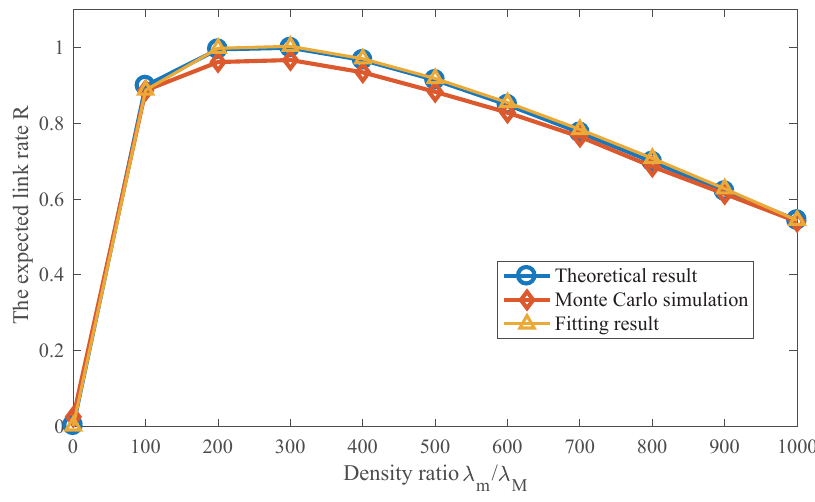
Figure 4. Comparison between the theoretical result and Monte Carlo simulation. P m / P M = 0.001.